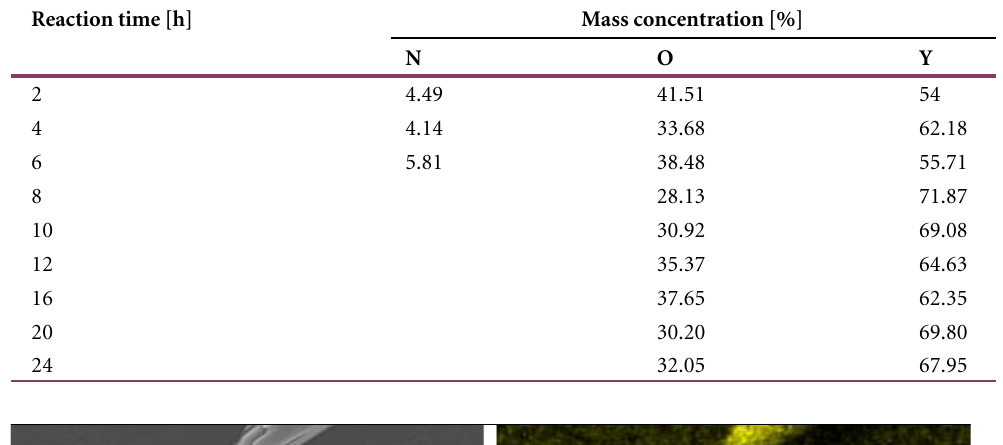
Table 3 Elemental analysis using energy dispersive x-ray spectroscopy.